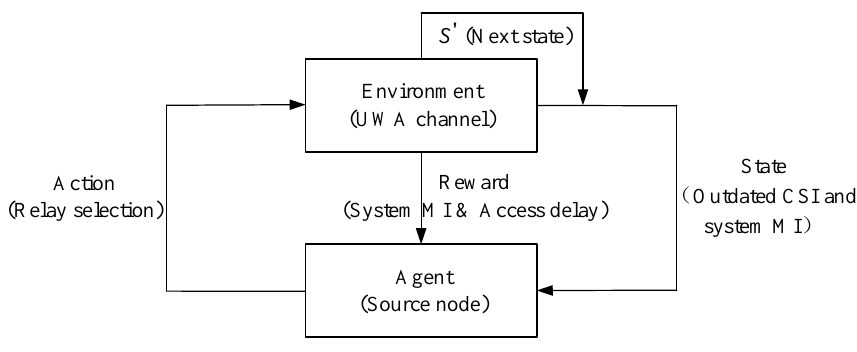
Figure 4. Framework of RL based UWA cooperative